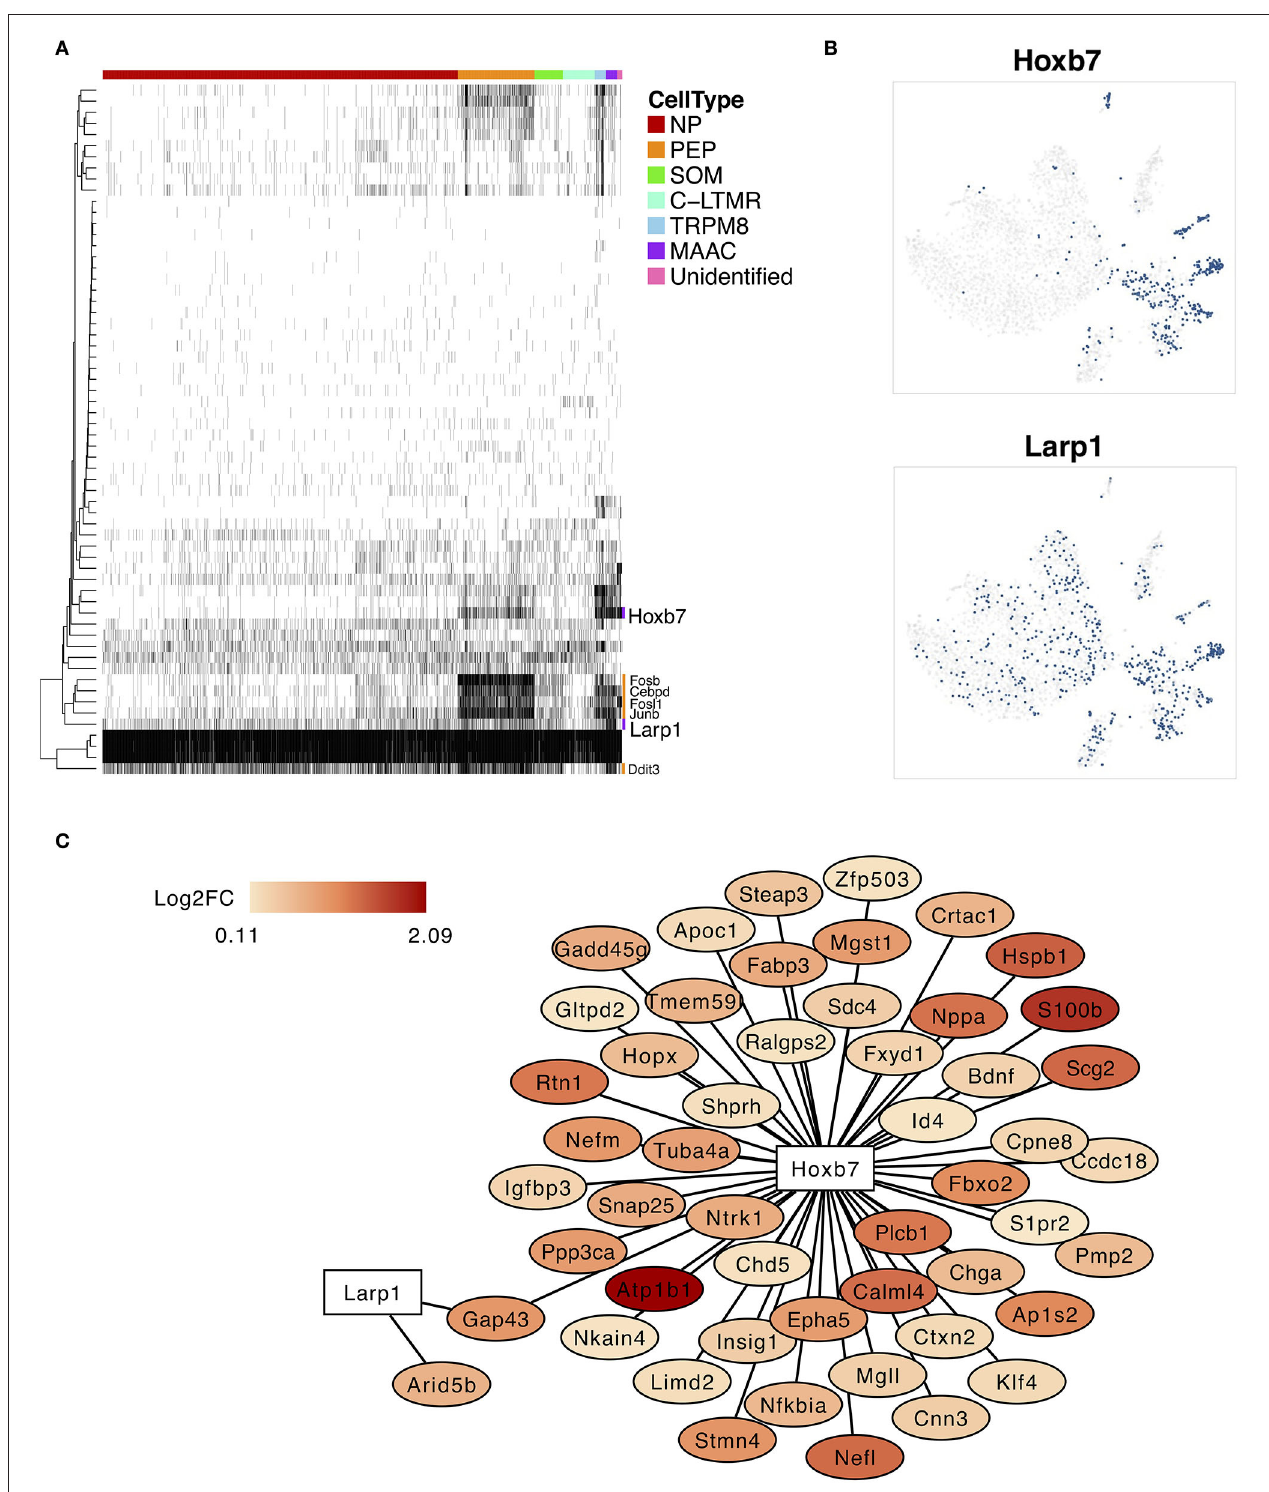
FIGURE 4 | Specifically expressed transcription factors and regulatory network of MAAC. (A) The binary heatmap shows the activity of inferred transcription factors in different neuron clusters. (B) t-SNE plots show the activities cells distribution of two specific expressed regulons of MAAC. Dots, individual cells; colors, activated cells. (C) Gene regulatory networks of Hobx7 and Larp1 inferred by single-cell regulatory network inference and clustering (SCENIC). Colors indicated the log2FC of DEGs of MAAC.